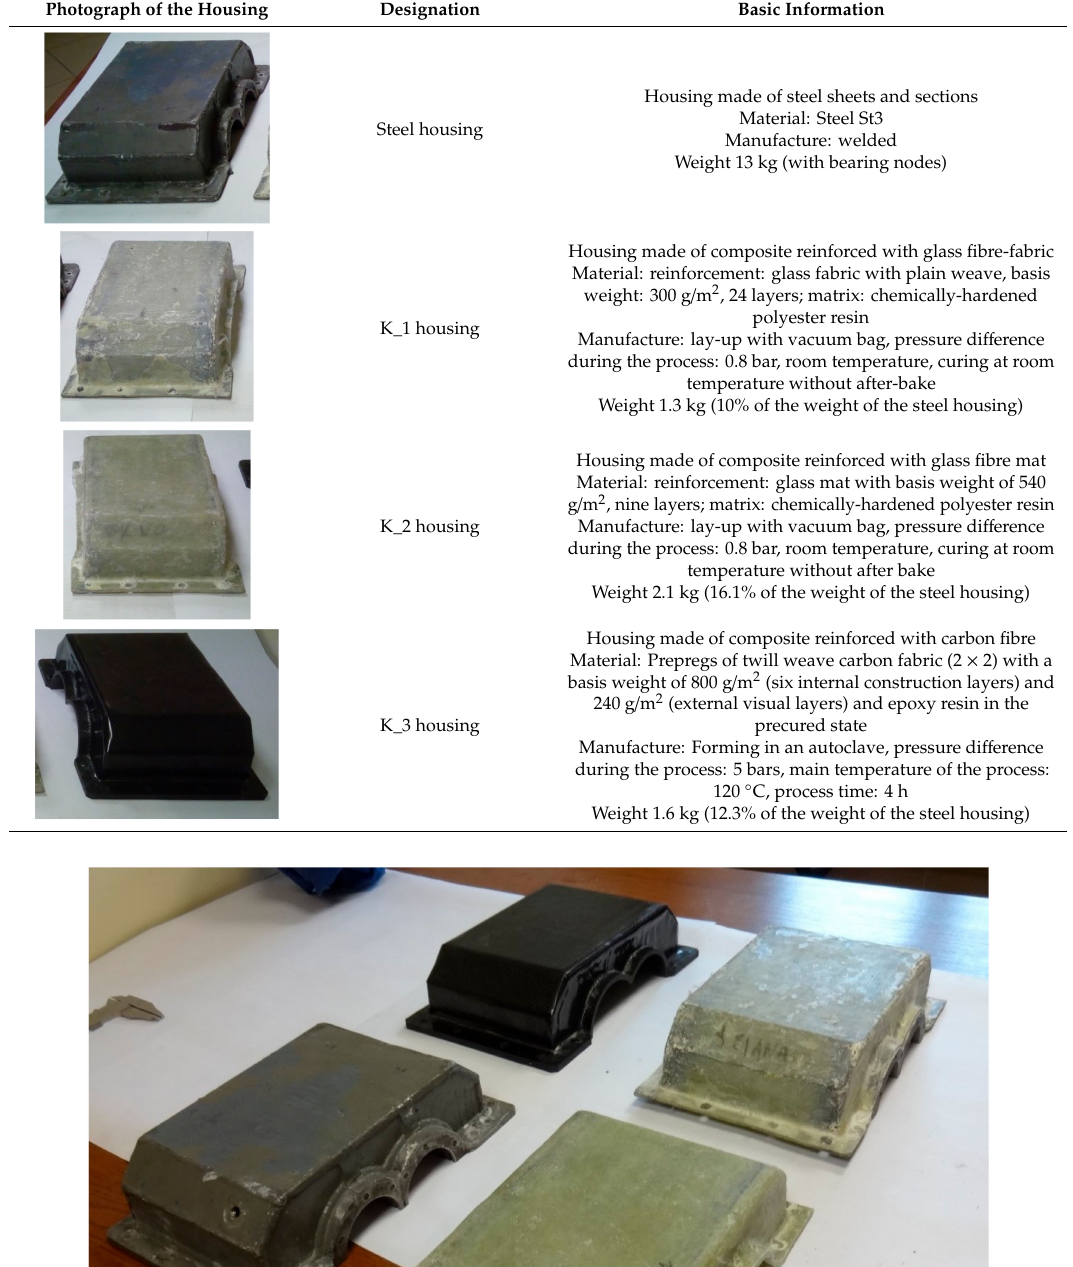
Table 1. Manufactured upper gearbox housings intended for tests.